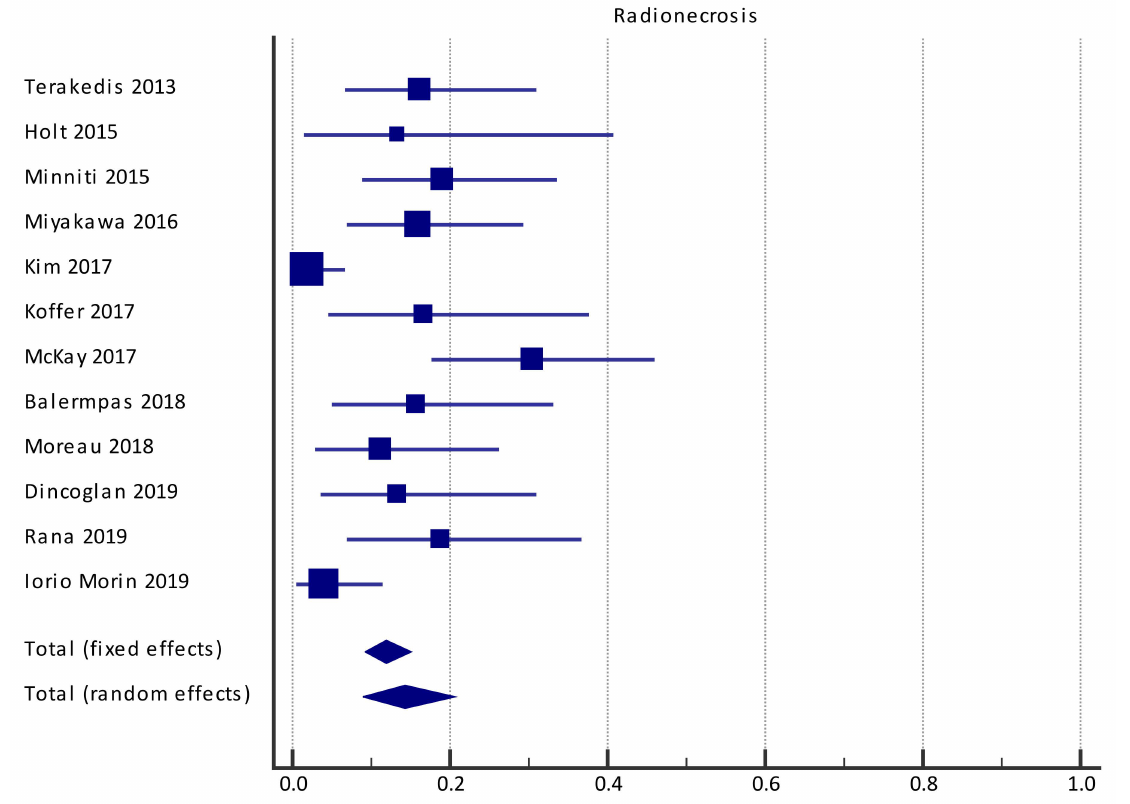
Figure 4. Forest plot of studies evaluating SRS2/SRT2: effect on